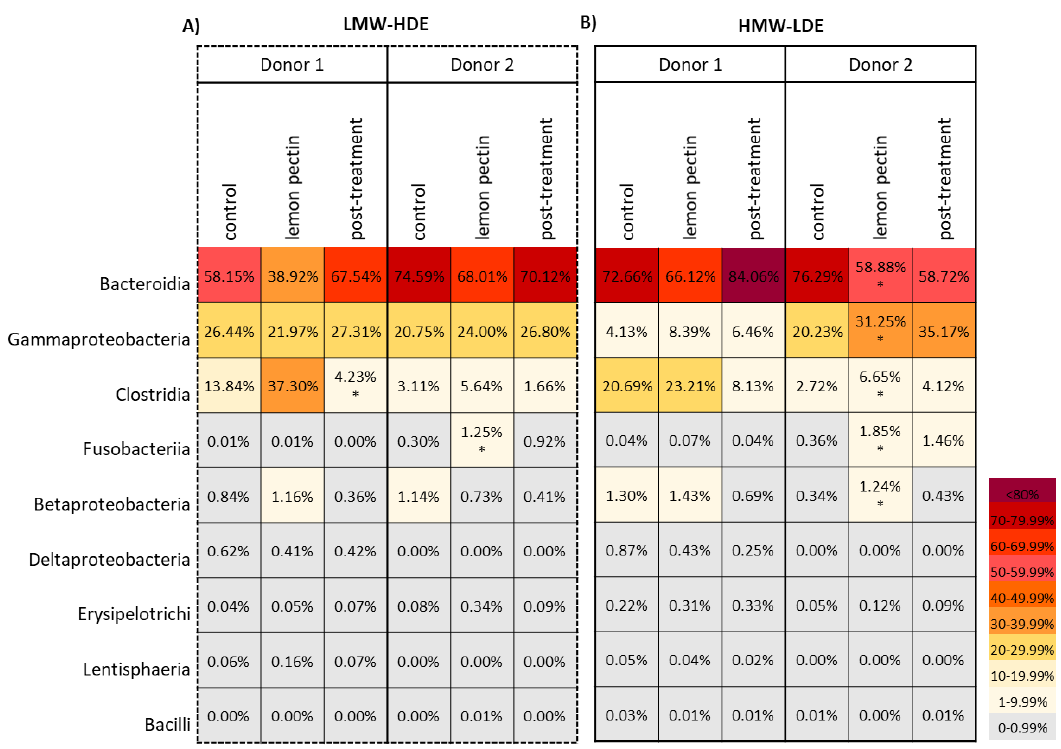
7 of 17 Figure 2. Principal Coordinate analysis (PCoA) based on weighted and unweighted UniFrac dis- tances for both donors during the control, lemon pectin treatment, and post-treatment periods. ( A ) LMW-HDE lemon pectin; ( B ) HMW-LDE lemon pectin.